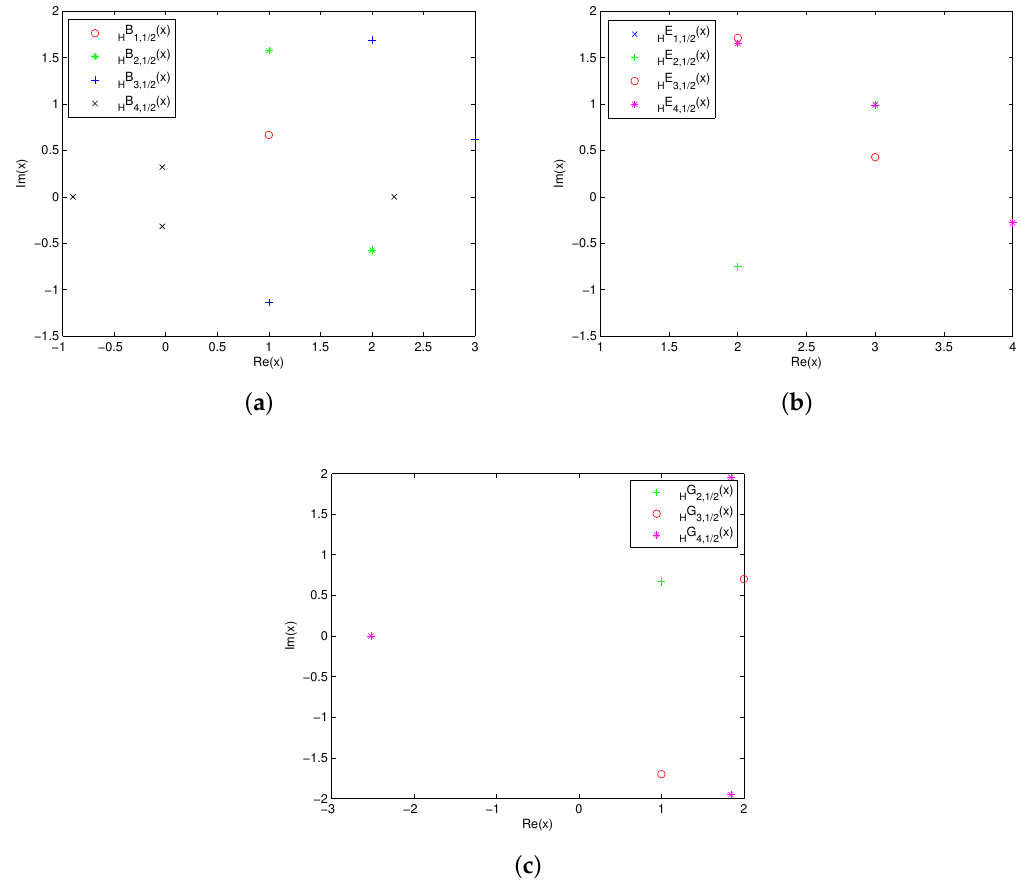
Figure 2. ( a ) Zeros of H B n ,1/2 ( x ) ; ( b ) Zeros of H E n ,1/2 ( x ) ; ( c ) Zeros of H G n ,1/2 ( x ) .